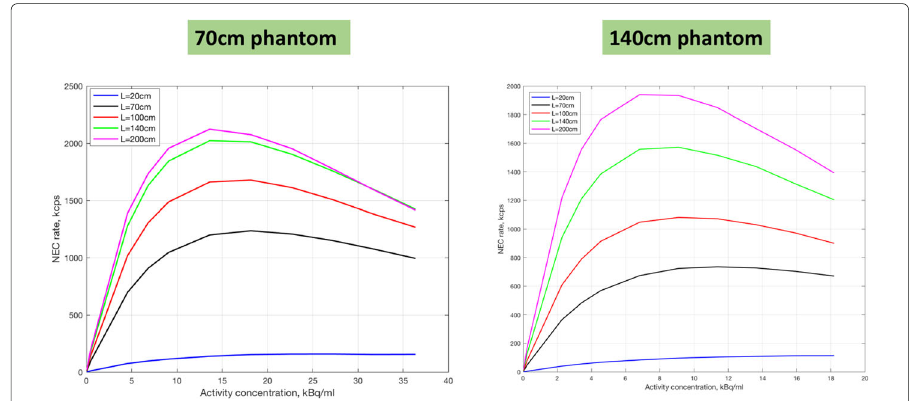
Currently, PET scanners are compared based on NECR (noise equivalent count